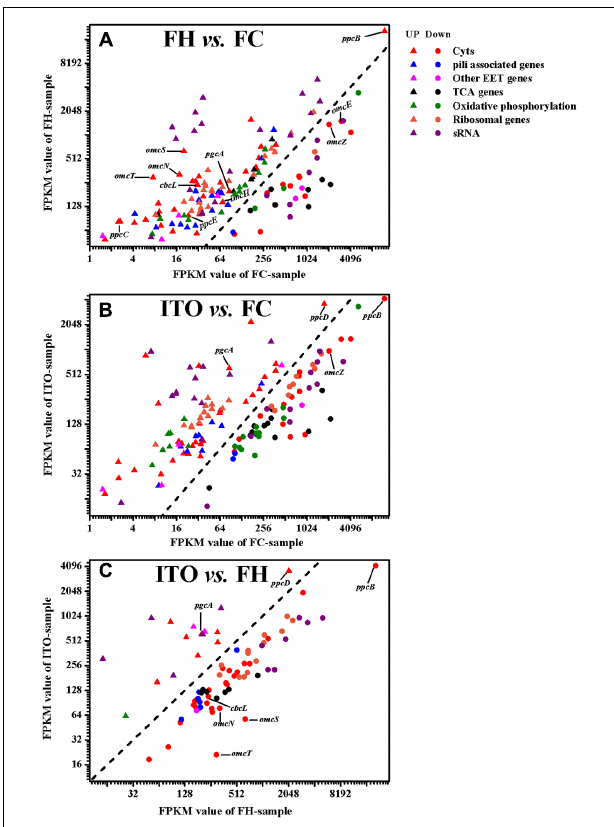
FIGURE 4 | Comparison of transcript levels of selected genes that were differentially regulated in G. soli cells grown with FH vs. FC (A) , ITO vs. FC (B) and ITO vs. FH (C) . The genes in this figure are listed in Supplementary Table S2. The slope of the dashed line is